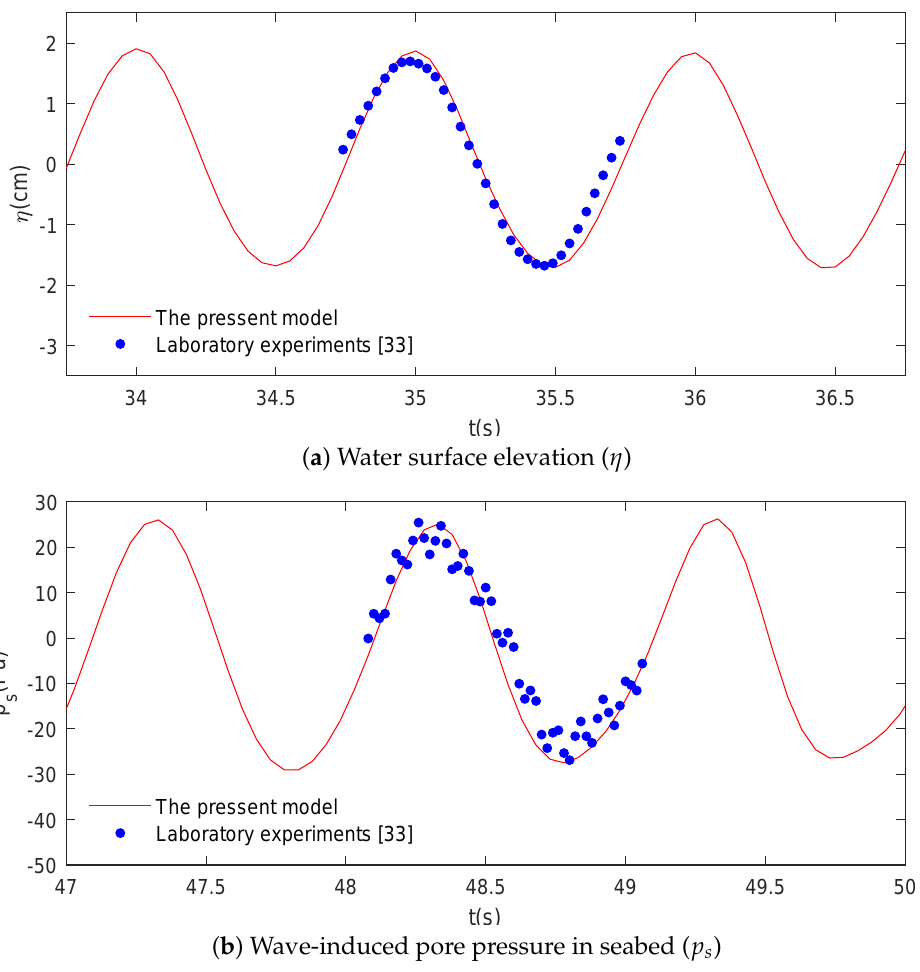
Figure 4. Validation of the present model with experimental data resulting from combining the wave and the following current loading [33]: ( a ) water surface elevation ( η ) and ( b ) the wave-induced pore pressure in seabed ( p s ). Input data: H = 5 cm, T = 1 s, d = 50 cm, h = 50 cm, S r = 1, G = 10 7 N/m 2 , µ = 0.3, K s = 1.88 × 10 − 4 m/s, n s = 0.771, current velocity ( U ) = 0.05